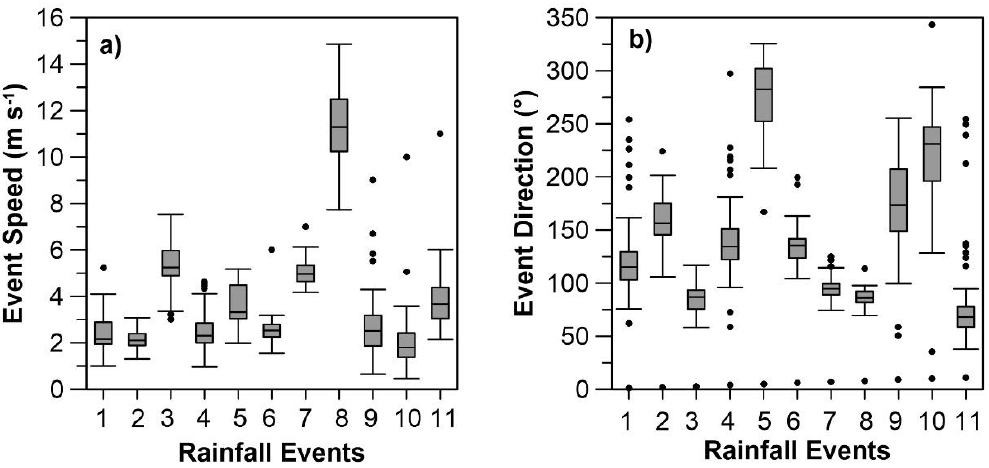
Figure 6. Distribution of ( a ) the speed and ( b ) the direction of the 11 rain events, calculated with the optical flow method using intensity gradient information on several image scales (PyrLK) advection model. Event direction means the angle of the origin of the rain cell (e.g., 90° = origin from the east).